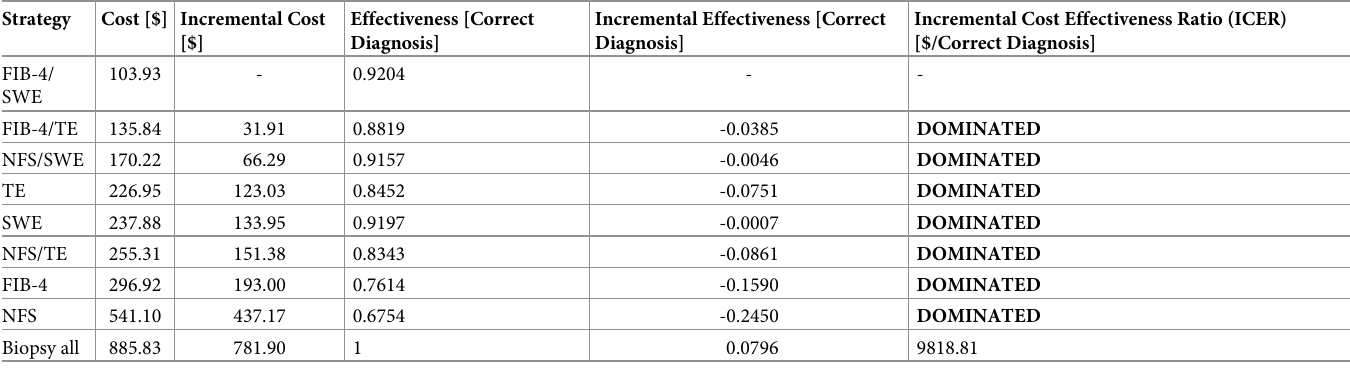
Table 4. Cost-effectiveness of finding F3 fibrosis in all patients.